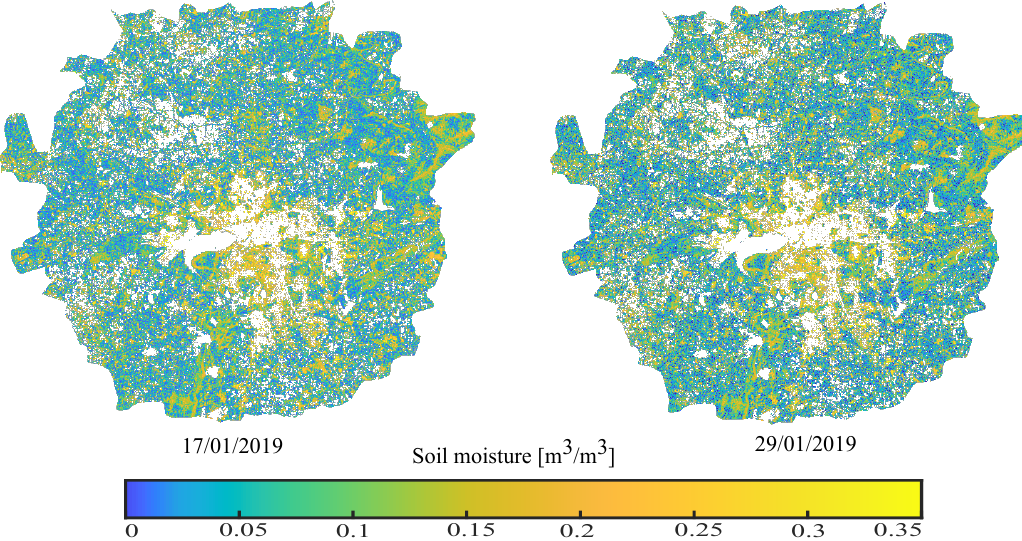
Figure 8. Spatial distribution of soil moisture estimated from Sentinel-1. Pixels shown in white correspond to the region where modified Dubois model is not